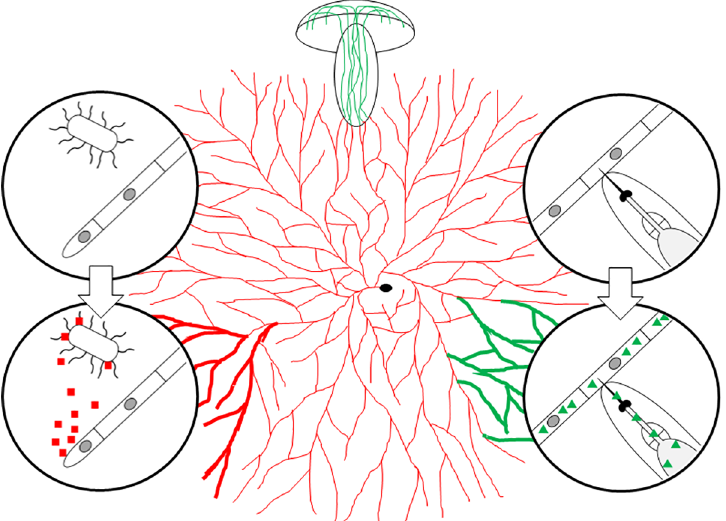
Fig 1. Regulation of the chemical defense of filamentous fungi (on the example of a mushroom) against microbial competitors and animal predators, exemplified by bacteria and fungivorous nematodes (adapted from Fig 1 in [9]). The fungus is represented by its vegetative mycelial network originating from a spore (black oval) and a fruiting body (mushroom) arising from that network. The circles show close ups on the competition between the fungal hyphae and bacteria (left) and predation by fungivorous nematodes (right) and the induction of respective fungal defense effectors; fungal nuclei are represented by grey ovals, extracellular antibacterial defense effectors by red squares, and intracellular defense effectors against nematodes by green triangles. Specific examples of antibacterial and antinematode effectors and their properties are listed in Table 1. Fungal hyphae producing the two types of defense effectors are colored respectively. Autonomous and antagonist-dependent production of defense effectors is indicated by thin and thick hyphae, respectively. The indicated spatial restriction of antagonist-dependent defense effector production in the fungal mycelium is